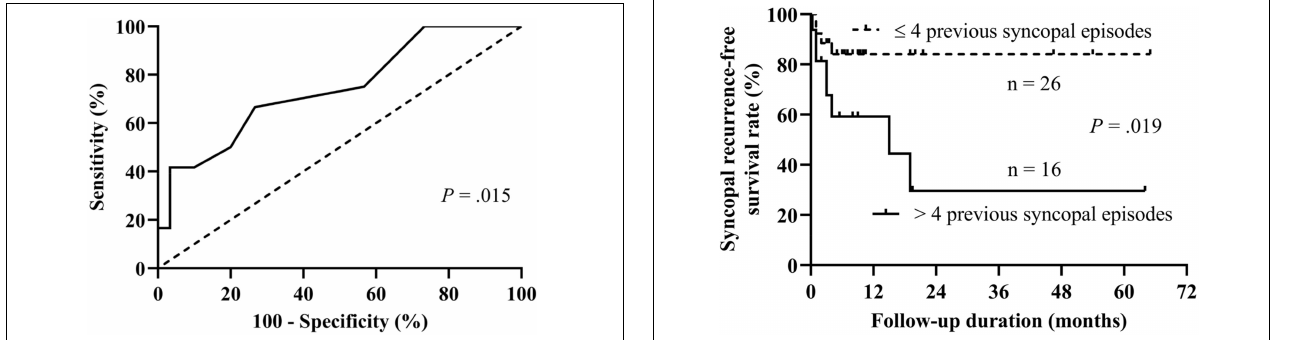
FIGURE 3 | Receiver operating characteristic curve for determining the best cutoff for the number of previous syncopal episodes in predicting syncopal recurrence. The y -axis represents the sensitivity to predict the recurrence of syncope; the x -axis represents the false-positive rate (100%–specificity%). The 45 reference line of the chart indicates that the sensitivity and the false-positive rate are equal. The area under the curve was 0.743 with a 95% confidence interval 0.574 to 0.912 ( P = 0.015).